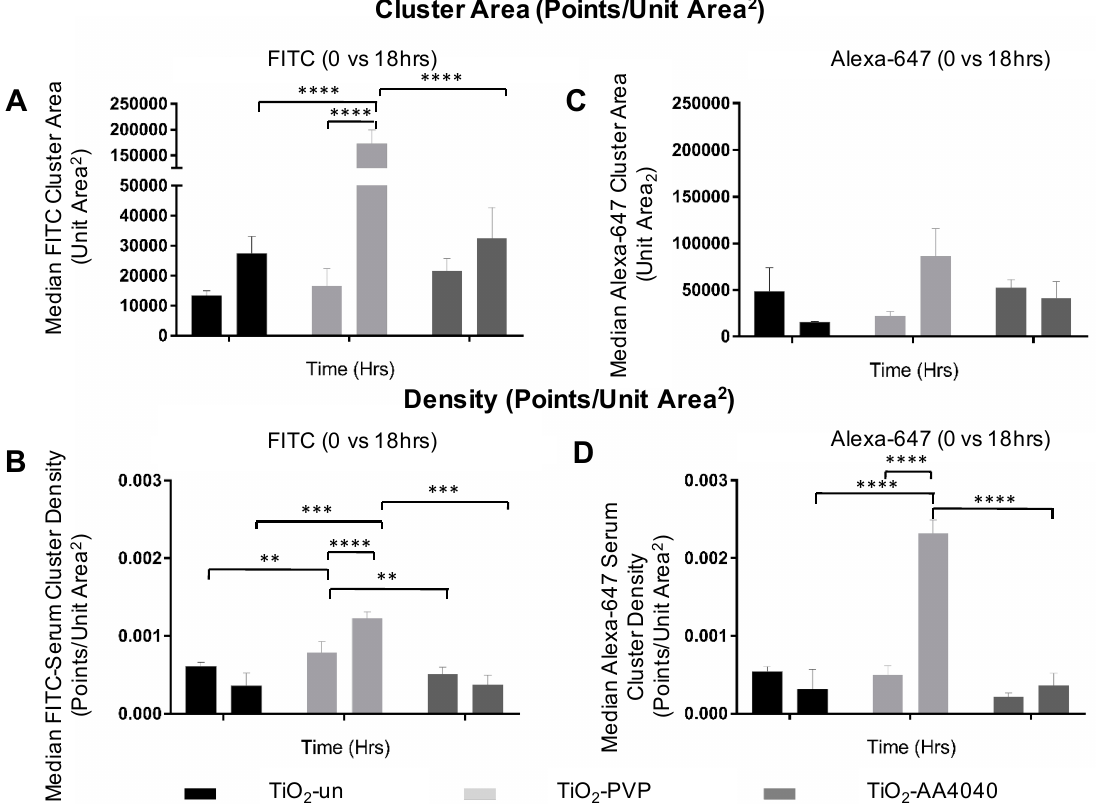
Figure 8. Cluster analysis of STORM data shows ( A ) a significant di ff erence in the FITC-serum cluster size between TiO 2 -PVP and its uncoated and AA4040-coated counterparts (**** p < 0.0001). ( B ) Similarly, the FITC cluster density is increased at 18 h when compared to TiO 2 -un and TiO 2 -AA4040, consistent with the retention of a densely-packed FITC-serum corona. Interestingly, no significant di ff erence in cluster area is observed in any of the observed samples ( C ); however, an increase in density is observed in the secondary Alexa-647-labeled protein at 18 hours in PVP-coated TiO 2 ( p < 0.0001) ( D ), suggesting the adsorption of Alexa-647-labeled protein to internalized PVP at this time point (two-way ANOVA with multiple comparisons, SEM, n = 3).